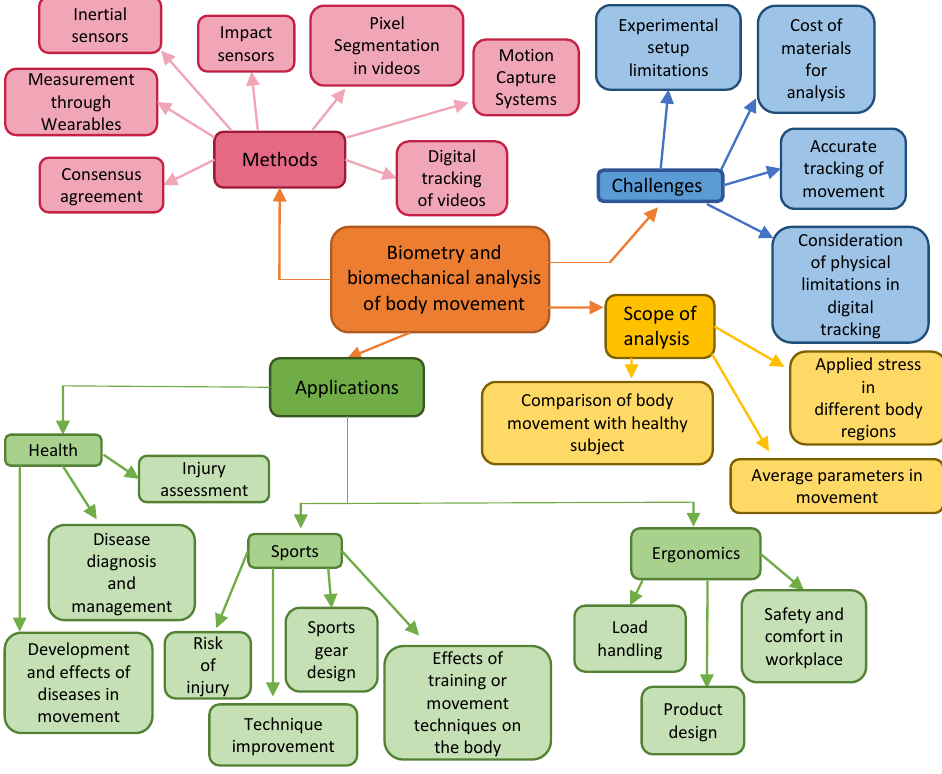
Figure 1. Taxonomy of the revised literature for methods, applications, scopes of analysis and challenges in Biometry and biomechanical analysis of body